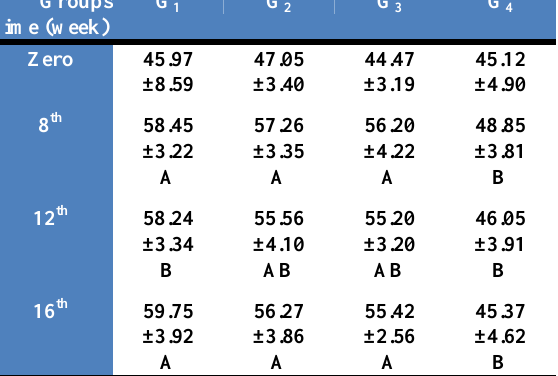
Table, 4: The effect of potassium nitrate and vitamin C as feed additive to the feed of rabbits on the serum urea (mg /